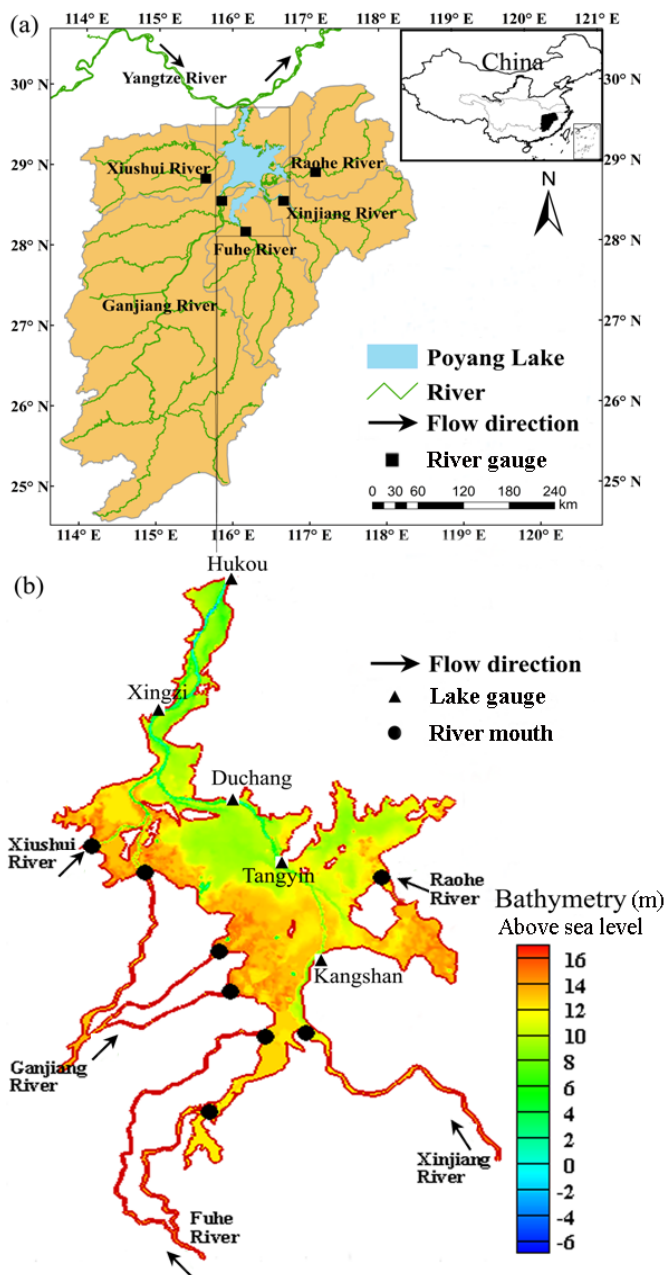
Figure 1. ( a ) Location of Poyang Lake-catchment, the main rivers and river gauging stations within its catchment; ( b ) Lake bathymetry, lake level gauging stations and river